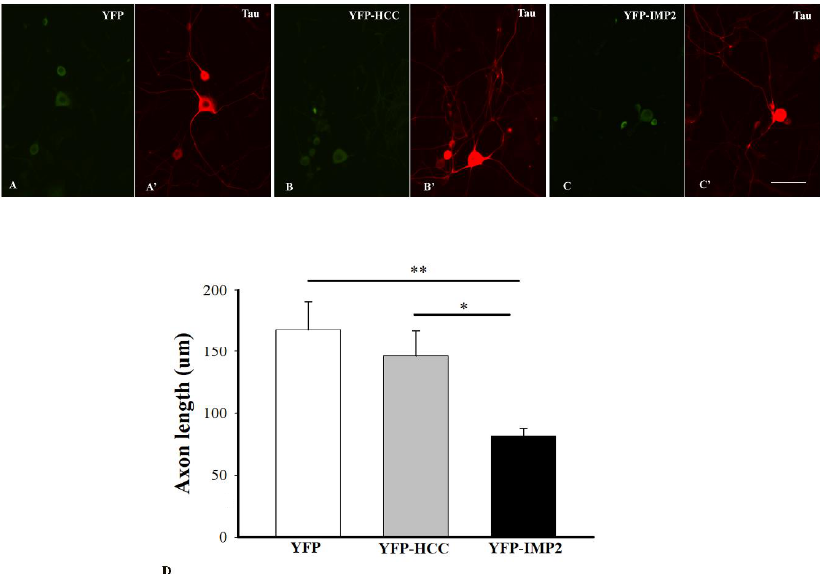
Figure 2. Transduction of the cultured DRG neurons by AAV9.hSyn.YFP, AAV9.hSyn.YFP-IMP2, and AAV9.hSyn.YFP-HCC. Most of the cultured DRG neurons are expressing YFP at 72 h after transduction by AAV9.hSyn.YFP. The DRG neurons transduced to express YFP ( A ), YFP-HCC ( B ), and YFP-IMP2 ( C ) are immunostained for tau ( A ’– C ’) to delineate the cell bodies and axons. ( D ) These axons were traced and quantified with ImageJ. Quantitative analysis shows a significant decrease in average axon length of the neurons overexpressing IMP2 when compared with that in the neurons overexpressing HCC or YFP only. Mean axon length ± s.e.m. are reported (N ≥ 40, * p < 0.05, ** p < 0.01). Scale bars: 25 µ